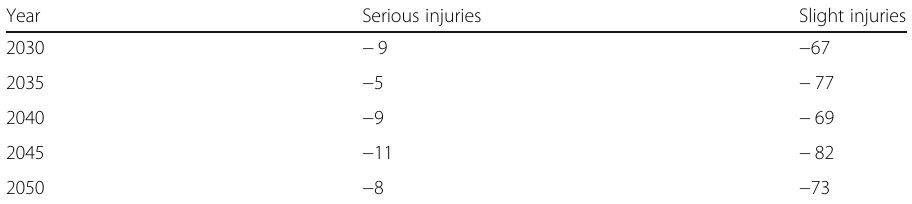
Table 7 Case study – Impact on road accidents p.a. (number of injured persons), EU28 + 2, difference